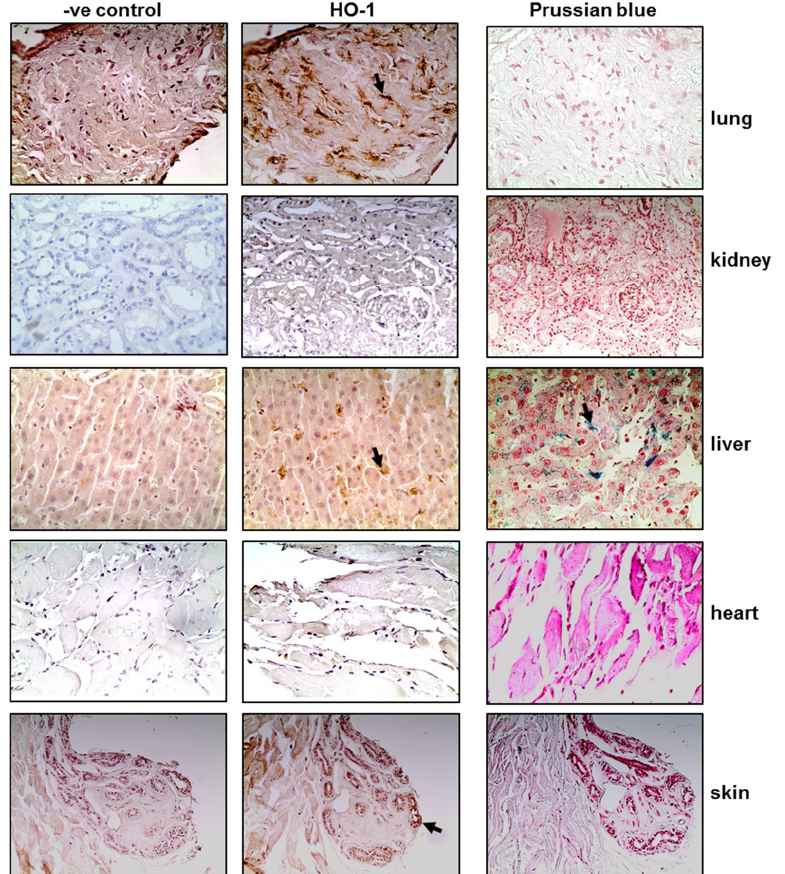
Figure 1. HO-1 upregulation and hemosiderin deposition in tissues of critical COVID-19 patients. Representative images from lung, kidney, liver, heart, and skin tissue sections obtained from critical COVID-19 patients autopsy samples and stained for HO-1 protein (and their respective controls) and Prussian blue. Magnification at × 400.